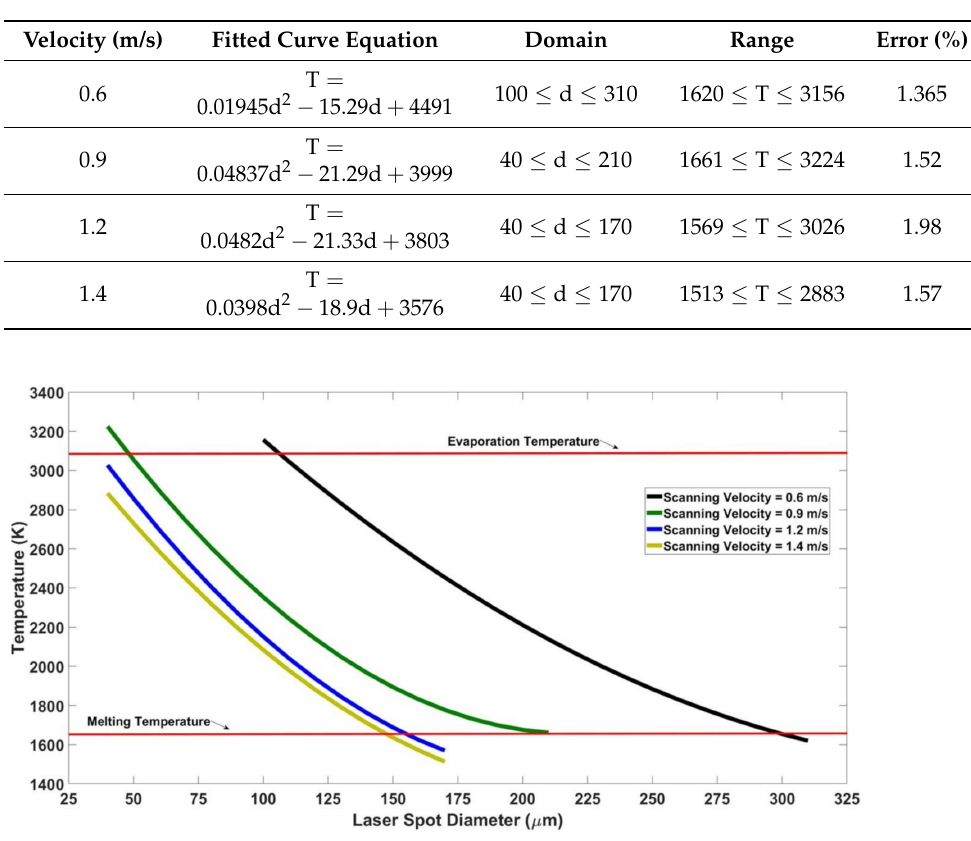
Table 6. Equations of fitted curves of laser spot diameter–temperature simulation results with a laser power of 150 W. In equations, T denotes the temperature (K) and d denotes the laser spot diameter ( µ m).